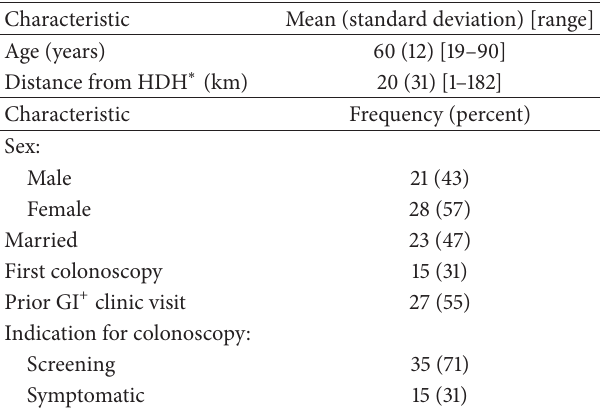
Table 1: Nonattender demographics.